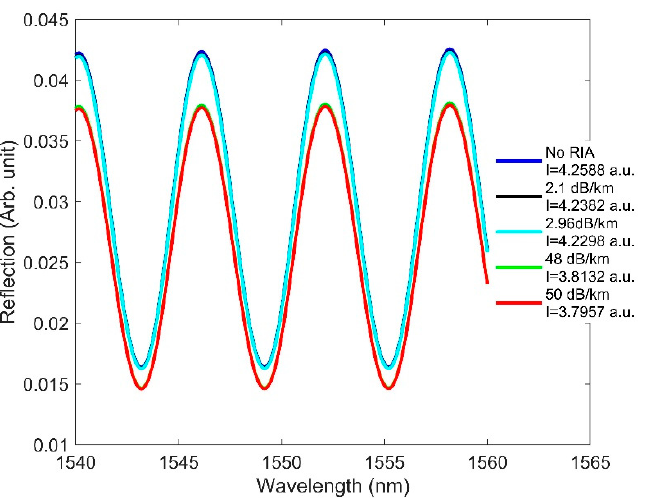
Figure 16. Effect of RIA on F-P at various doses, using the same design parameters applied earlier.